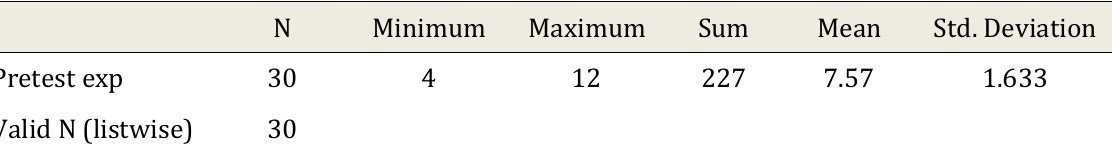
Table 4.15 The Mean Score of Students' Pretest in Experimental Class